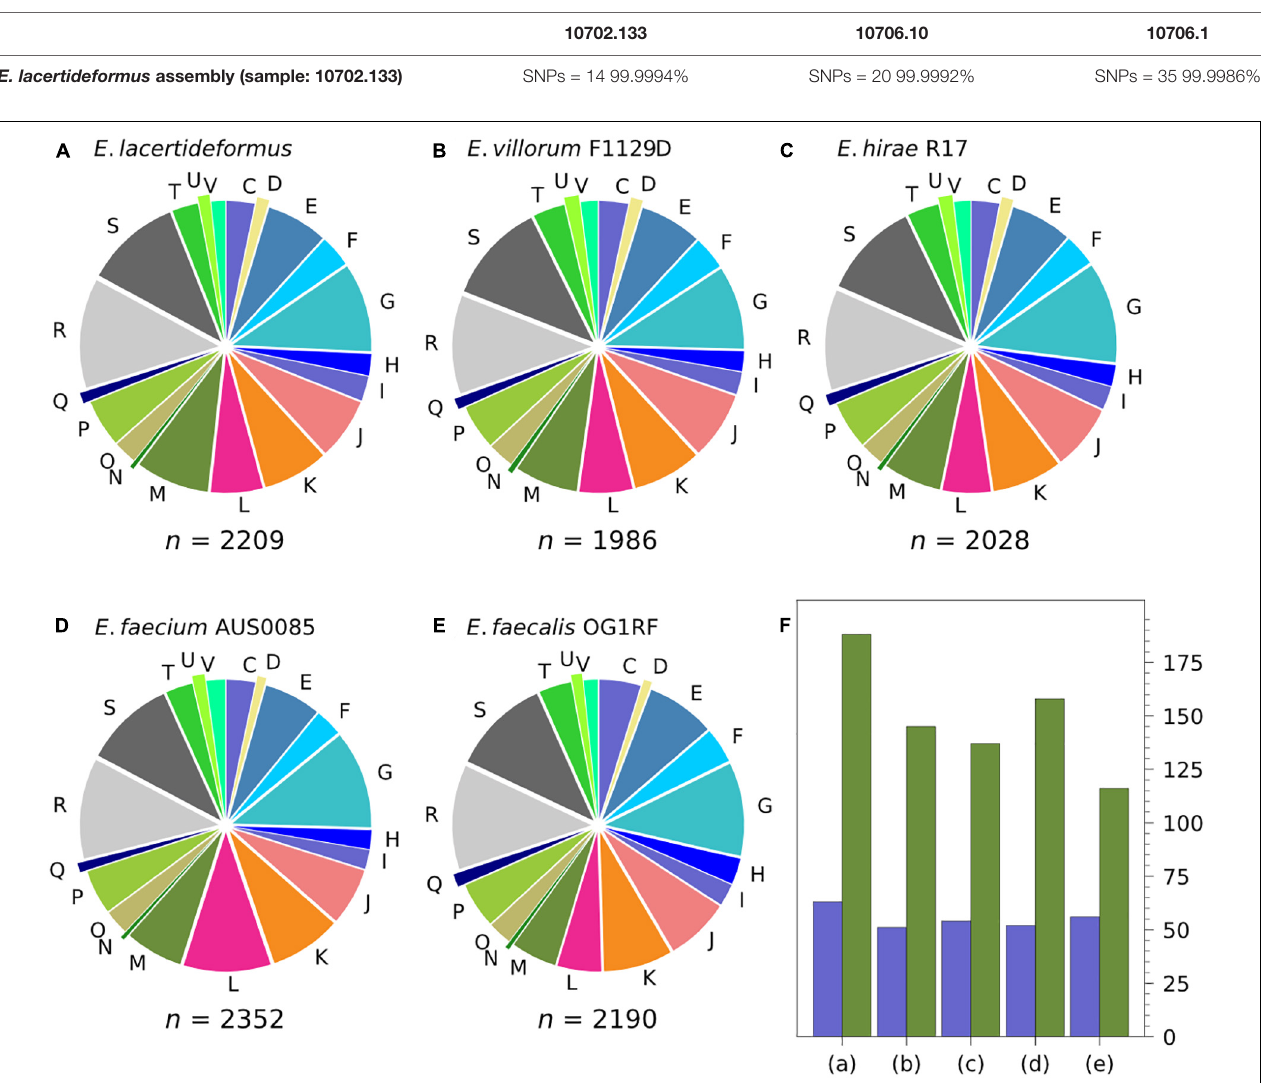
TABLE 3 | Pairwise comparisons (SNPs and nucleotide similarity percentage) of three E. lacertideformus sample reads to the final E. lacertideformus assembly (sample: 10702.133).